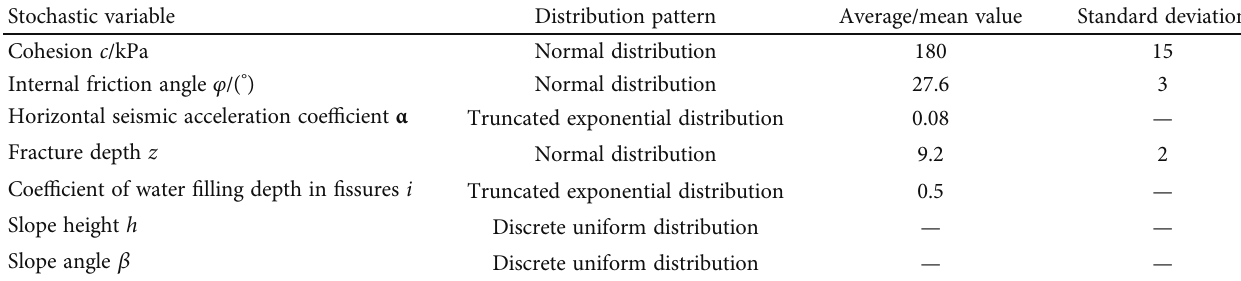
Figure 10: Slope calculation model. Table 14: Parameter distribution of random variables.